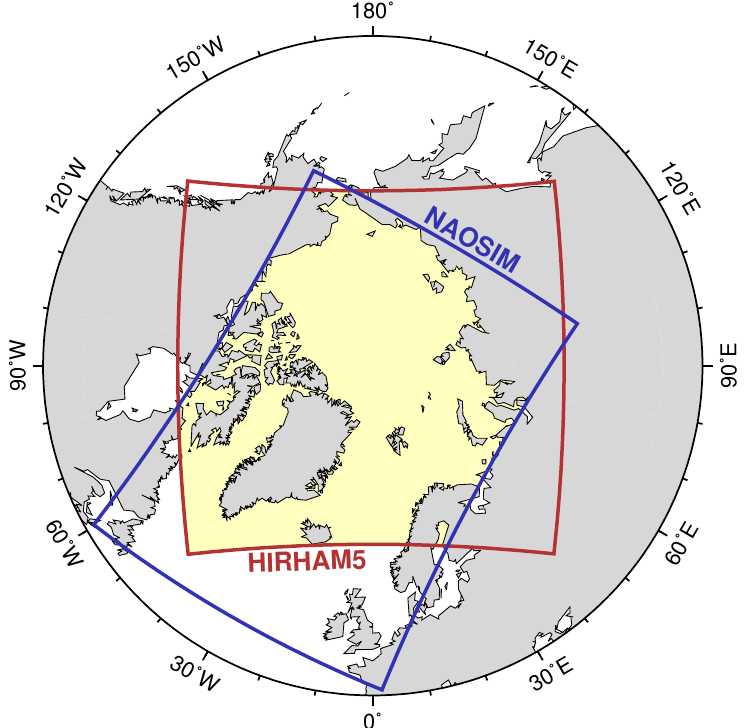
Figure 1. Geographical location of the regional model domains of the atmosphere component HIRHAM5 and of the ocean–ice component NAOSIM. The coupling domain is indicated by the yellow area and comprises 20,583 (out of 43,600) HIRHAM5 grid cells and 200,951 (out of 366,850) NAOSIM grid